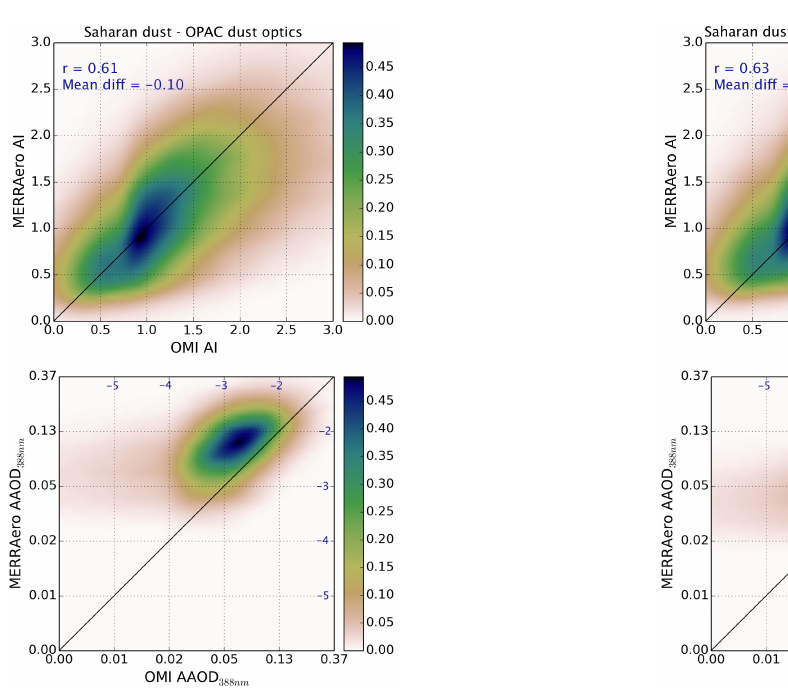
Figure 7. Comparison of MERRAero-simulated AI (top) and AAOD at 388nm (bottom) to OMI retrievals for the period JJA 2007 over the Saharan dust region. The dust OPAC optics table is used in MERRAero simulations.